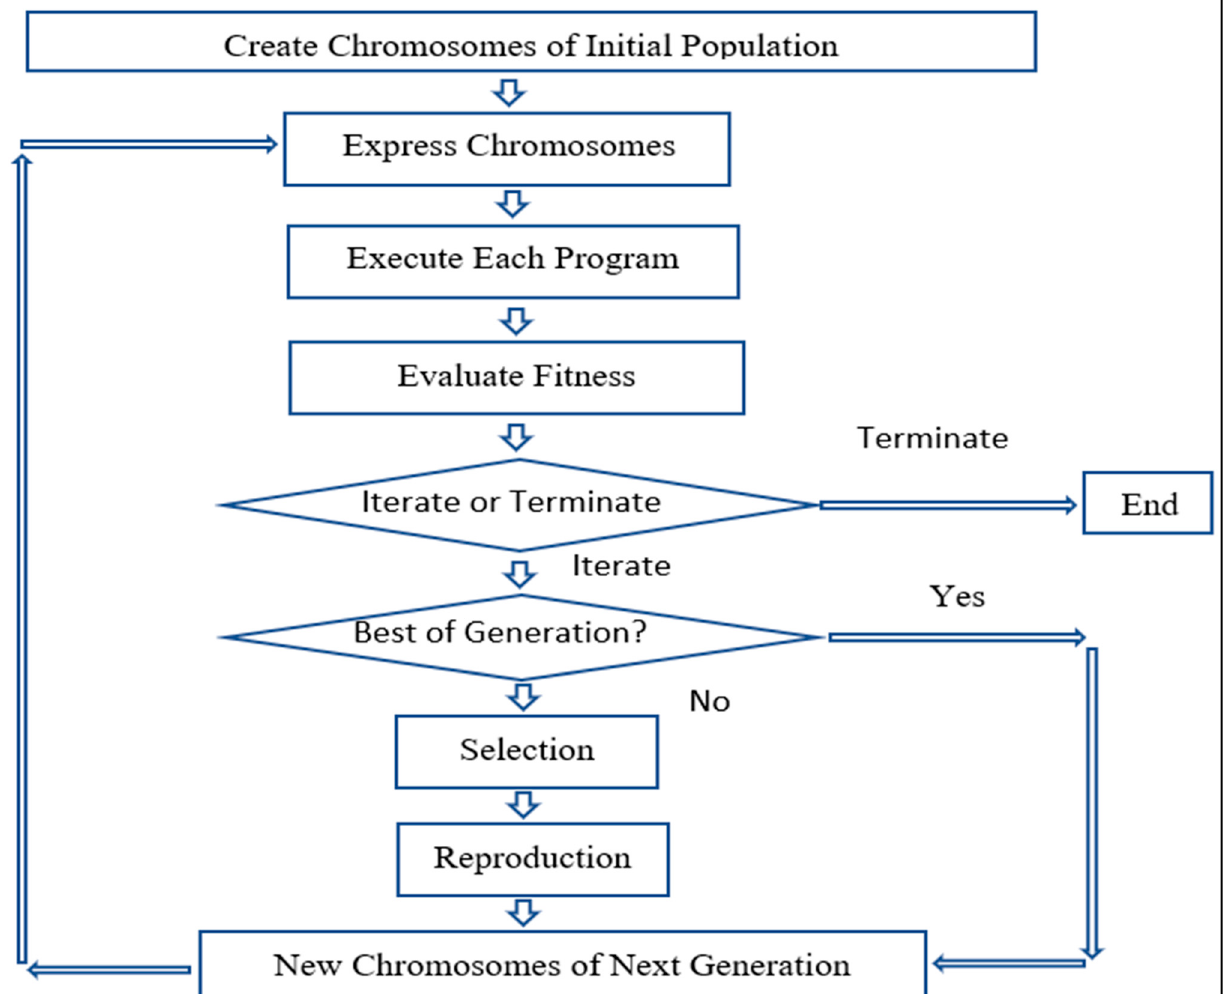
Figure 2. Simple Algorithm of Gene Expression Programming.